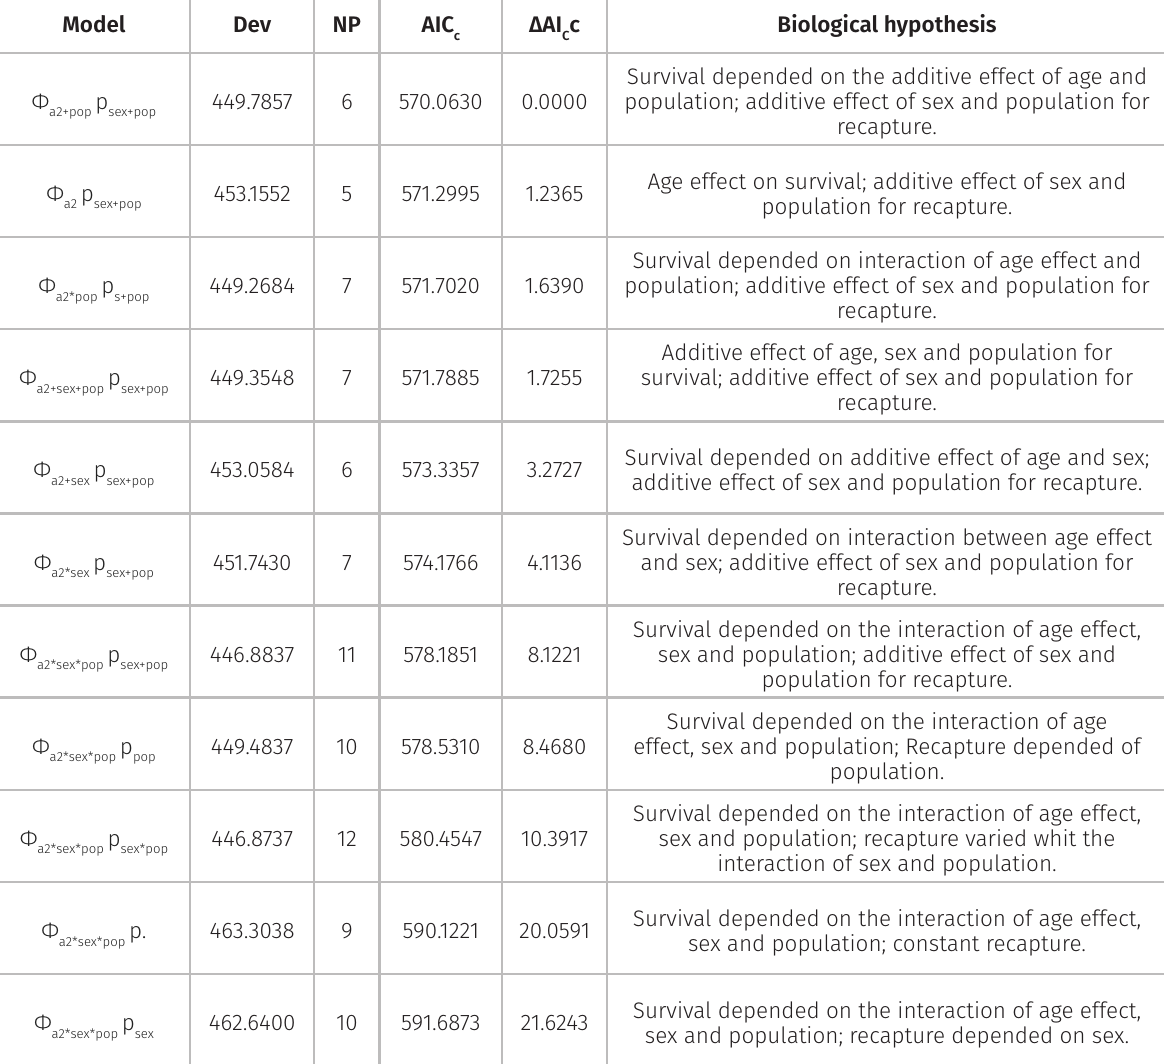
Table II. Survival models and associated biological hypotheses for Homonota taragui in Paraje Tres Cerros. The most supported model is in bold. Model notation: Φ , apparent survival probability; p , recapture probability, sex , sex (females and males); pop , population (Chico, Nazareno); a2 , two-class age effect (different probability in the 1 st vs the subsequent intervals after the first capture); + , additive effect; * , non-additive effect. Table notation: Dev , deviance of the model; NP , number of identifiable parameters; AIC , Akaike information criterion value corrected c for small sample size; ΔAIC , difference in AIC values between the current model and that with the lowest AIC value. c Model Dev NP AIC ΔAI c Biological hypothesis c C Survival depended on the additive effect of age and 0.0000 population; additive effect of sex and population for